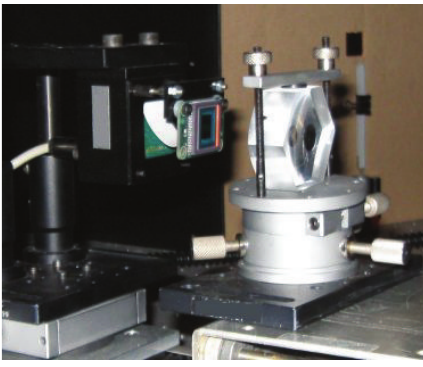
Figure 12: CMOS camera examining a small solar